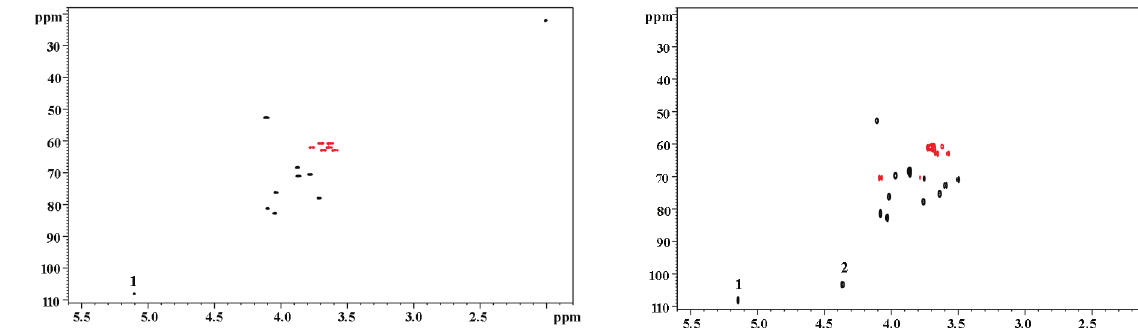
Figure 2 - 1 H- 13 C HSQC spectrum of the monosaccharide alditol from epimatigotes of T. cruzi strain Silvio X10/1 (CH black, CH red). 1. Gal f -β-1-4-GlcNAc-ol. 2